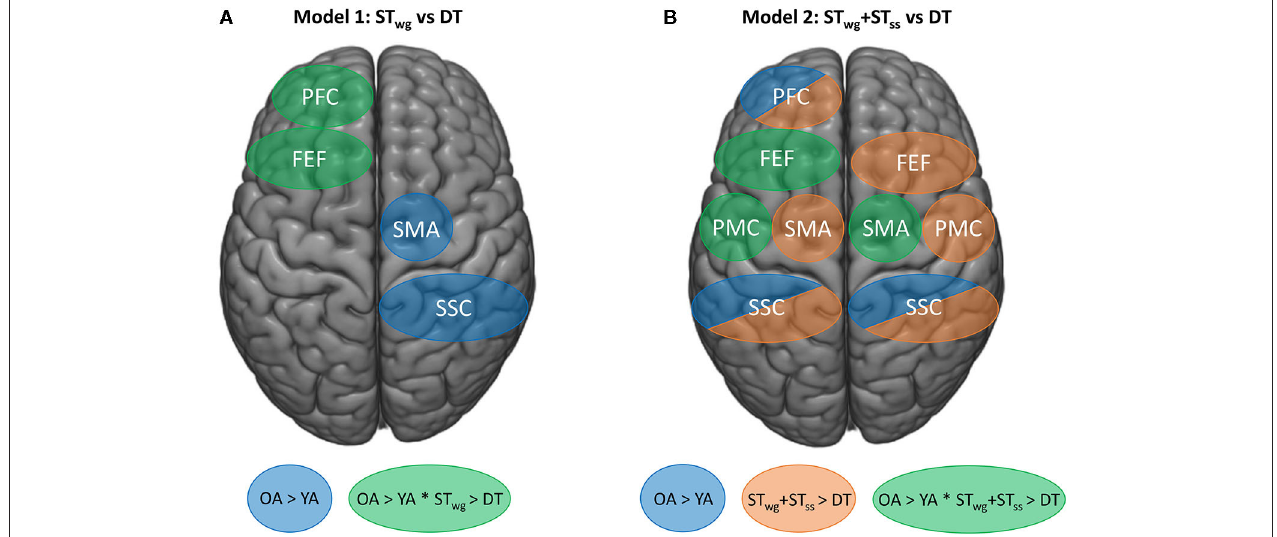
FIGURE 6 | Schematic overview of the fNIRS findings on HbO 2 levels for mixed model 1 (ST wg vs DT) (A) , and mixed model 2 (ST wg + ST ss vs. DT) (B) . Blue areas represent group effects ( p < 0.05) with higher HbO 2 levels in OA vs. YA. Task effects are displayed by orange areas ( p < 0.05), representing lower HbO 2 levels in the DT compared to ST wg + ST ss . Green areas represent interaction effects ( p < 0.05) with higher HbO 2 levels in OA vs. YA during ST wg and ST wg + ST ss and greater HbO 2 level reductions in OA vs. YA during DT. ST wg , single-task wasp game; ST ss , single-task serial